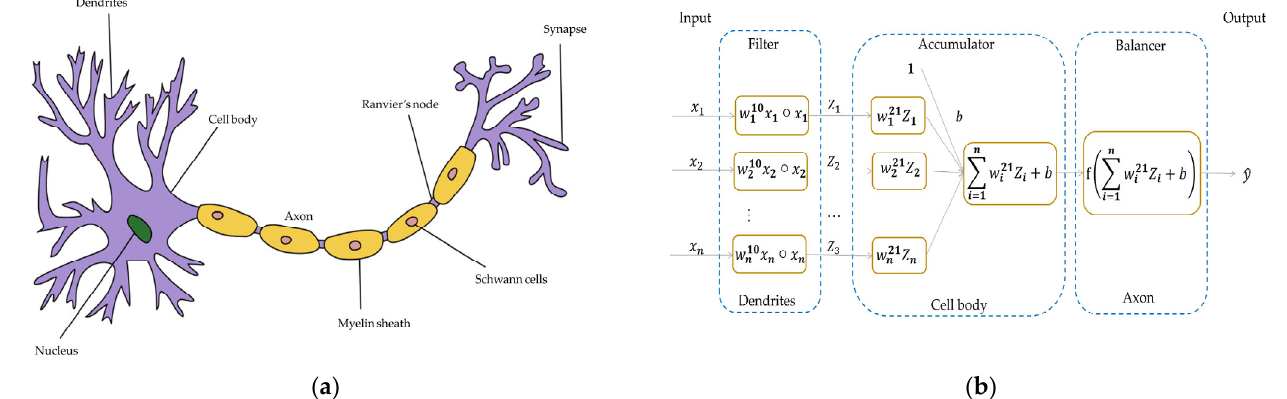
Figure 3. The structure of neurons: ( a ) biological neuron structure; and ( b ) functional structure diagram of dendritic neuron model.